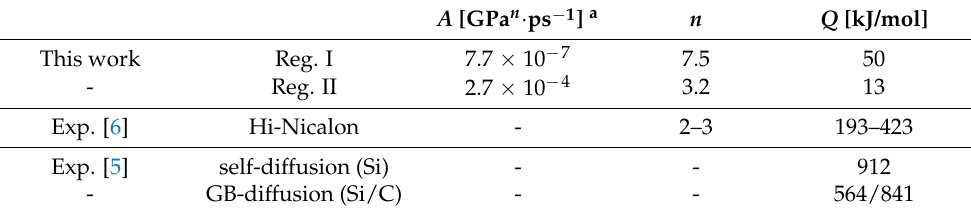
Table 3. The fitted parameters for the relationship of the stress and the strain